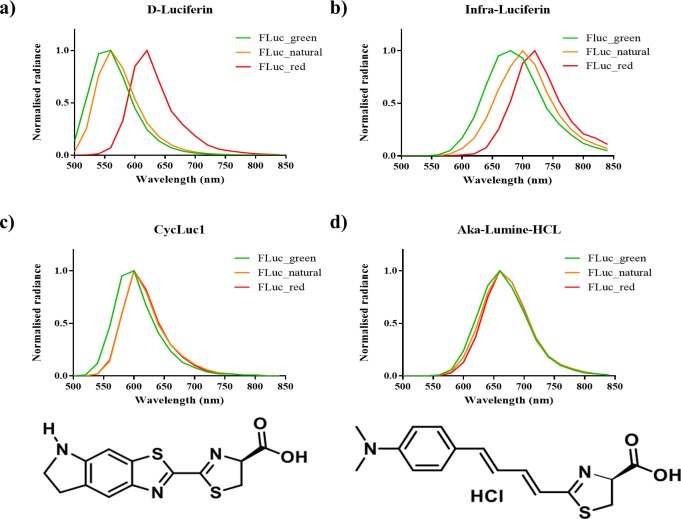
Bioluminescence spectra of x11 FLuc mutants FLuc_natural, FLuc_green and FLuc_red with LH2 analogues.(a) LH2, (b) iLH2, (c) CycLuc1 and d) Aka-Lumine-HCL) in vitro, alongside the chemical structure of CycLuc1 and Aka-Lumine-HCL below the corresponding spectra). Spectra normalised to peak emission for each FLuc mutant with each substrate. Each point on the x-axis gives the midpoint of the 20 nm band pass filter used in spectral imaging.